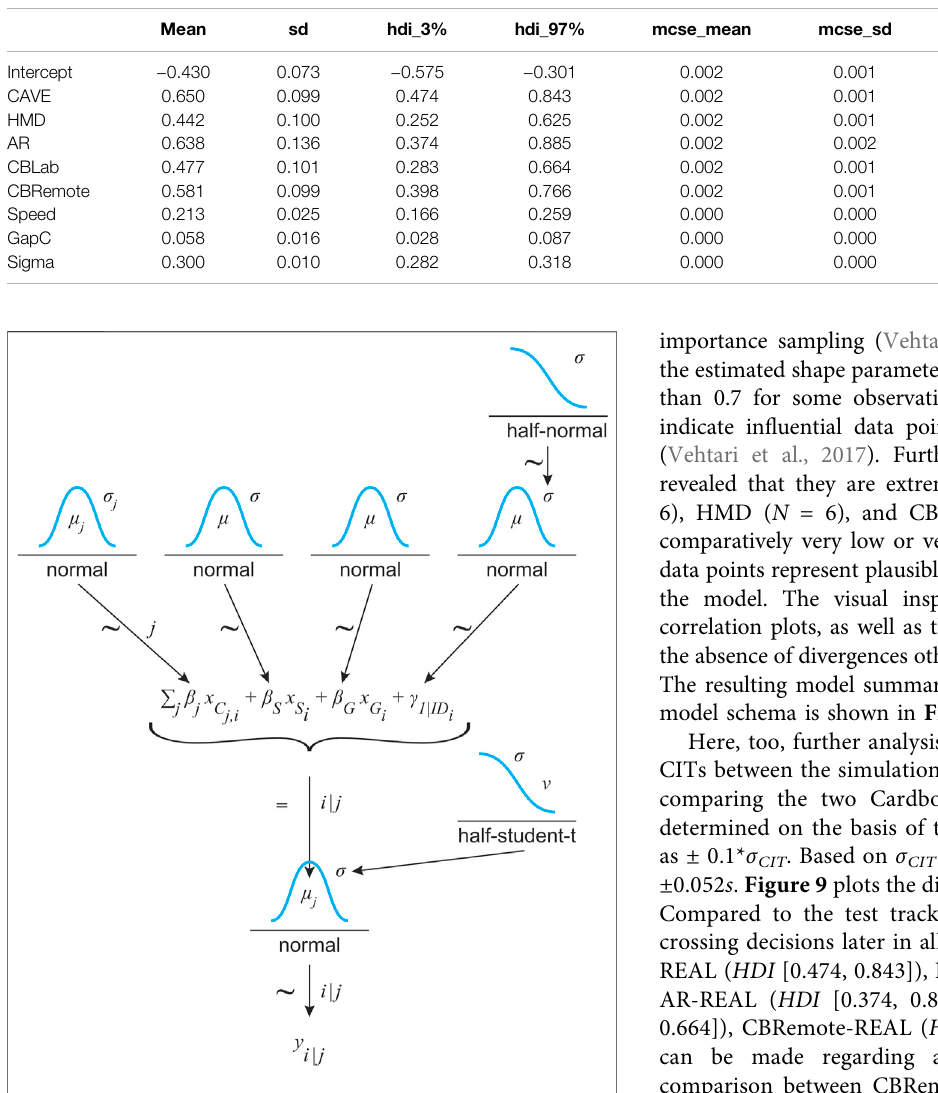
FIGURE 8 | Model structure for predicting CIT ( y i ) depending on the simulation environment ( j ) and based on a Gaussian distribution. Its μ value results from a linear function with condition (C, 6 categorical levels referenced by index ( j ), speed ( S ) and gap size ( G ) as fi xed effects. The standard deviation of the Gaussian distribution σ is estimated on the basis of a weakly informative normal prior distribution. Due to the repeated measures design, the participants ’ ID was treated as a random effect ( c ). The estimators were assignedweaklyinformativepriors:normaldistributionforthe fi xedeffectsand half-normal for the σ of the normal distribution for the random